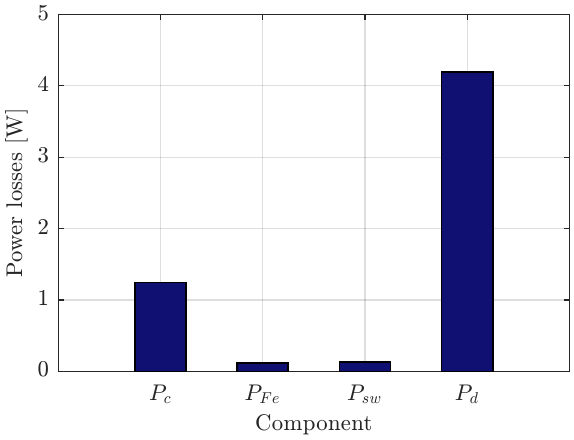
Figure 6. Optimization results: Separation of power losses for the optimal P18/11 resonant pot core design; Joule ( P c ), iron ( P Fe ), switch ( P sw ), and diode losses ( P d ),